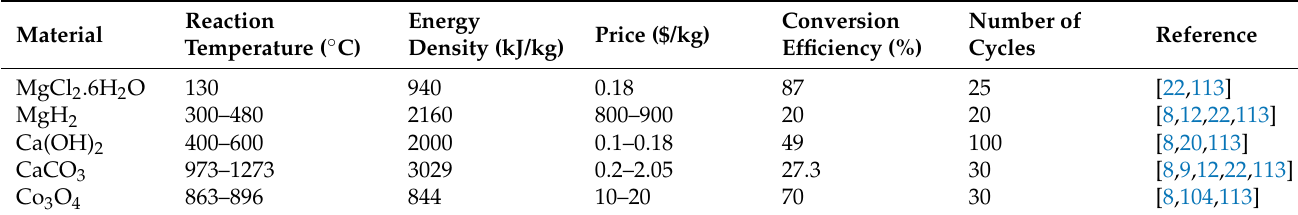
Table 5. Comparison of cost, efficiency, and charge/discharge cycles of TCES